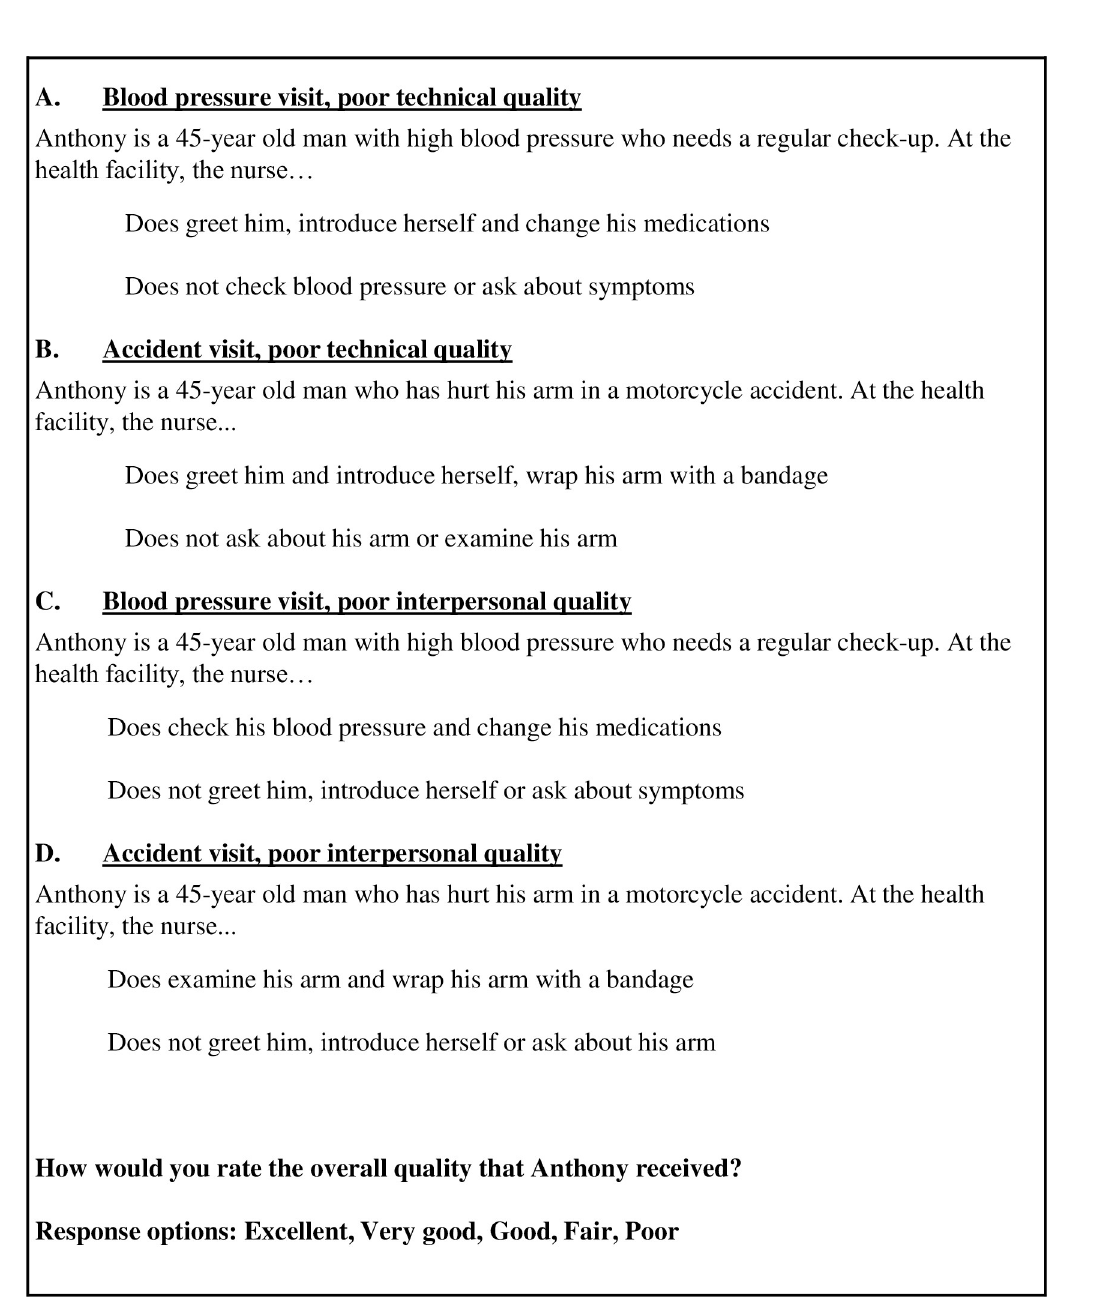
Fig 1. Vignettes describing poor-quality care. All respondents received vignette A. A subset of respondents also received vignette B, C, or D. Please see S1 Appendix for full survey instrument and S2 Appendix for survey